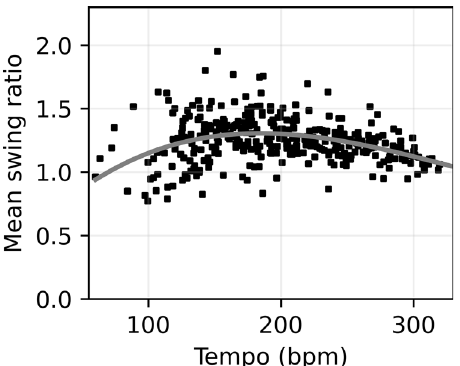
Fig. 2 Mean swing ratios of soloists as a function of tempo. Each point corresponds to a piece of the Weimar Jazz Database 29 and represents the soloist's averaged swing ratio as a function of tempo. A quadratic fi t to the data (gray line) as an indicator of preferential swing ratios reveals an increasing trend as a function of tempo up to 160 bpm and a decreasing trend above 160 bpm. The swing ratio of most soloists lies below 1.5, thus is much smaller than generally believed, and does not correspond to a triplet feel (i.e., swing ratio